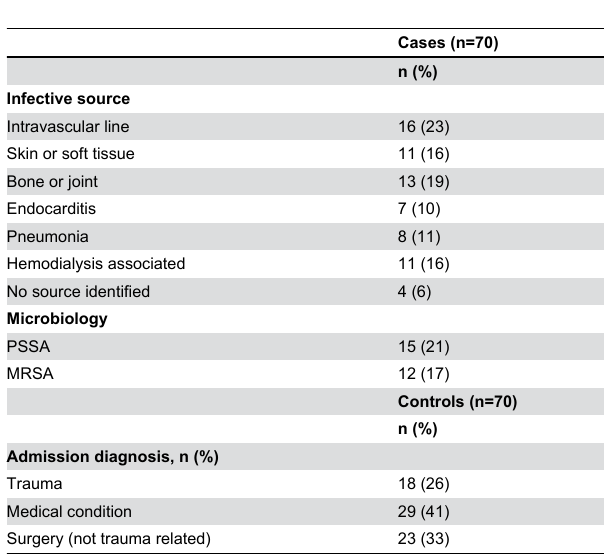
Table 1. Clinical characteristics of S. aureus BSI cases and